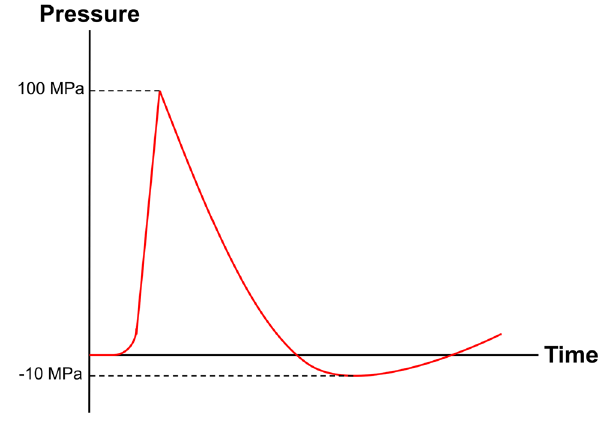
Fig. 11 Scheme of a therapeutic